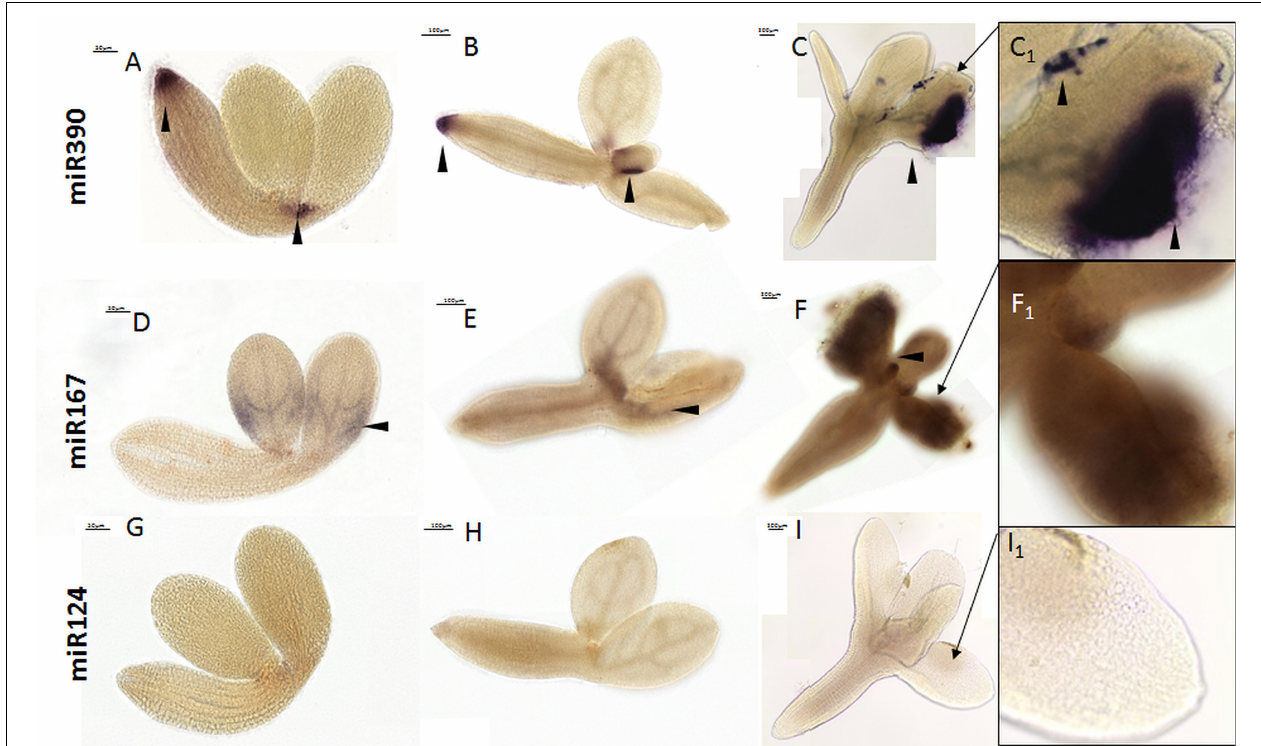
FIGURE 2 | Whole mount in situ hybridization of the miR390 and miR167 molecules in the explants undergoing SE induction in 0th day (A,D,G) , 5th day (B,E,H) , and 10th day (C,F,I) . Probe against the mouse miR124 were used as the negative control. A higher magnification views of the SE-involved cotyledons on the 10th day of the SE culture are presented in black boxes (C 1 , F 1 , and I 1 ). Arrow heads indicate the detected signal.